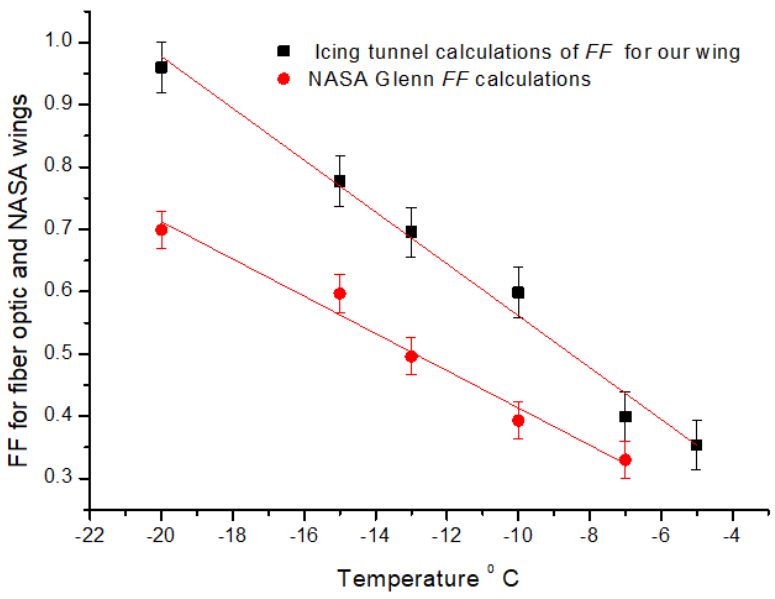
Figure 14. Comparison of icing tunnel calculated FF using Messinger’s relation [20], for wing in NASA Glenn icing tunnel (red), and FF for wing incorporating the fiber array ice sensors in GKN icing tunnel (black).